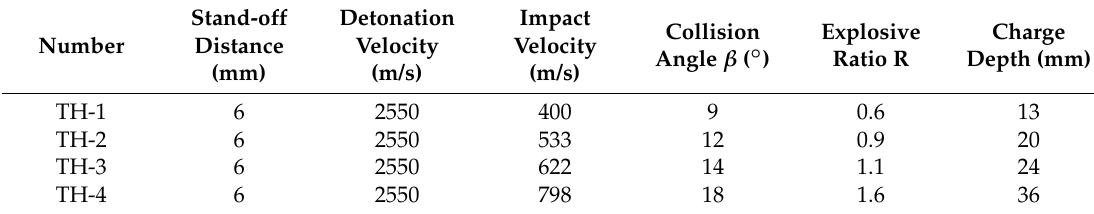
Table 3. Explosive welding parameters for different welding